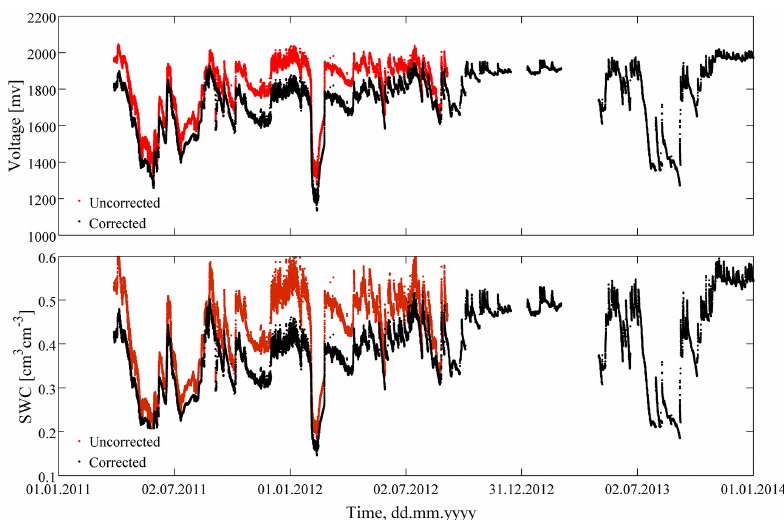
Figure 6. Time series of the uncorrected (red) and corrected (black) voltage and soil water content (SWC) measurements of one representative